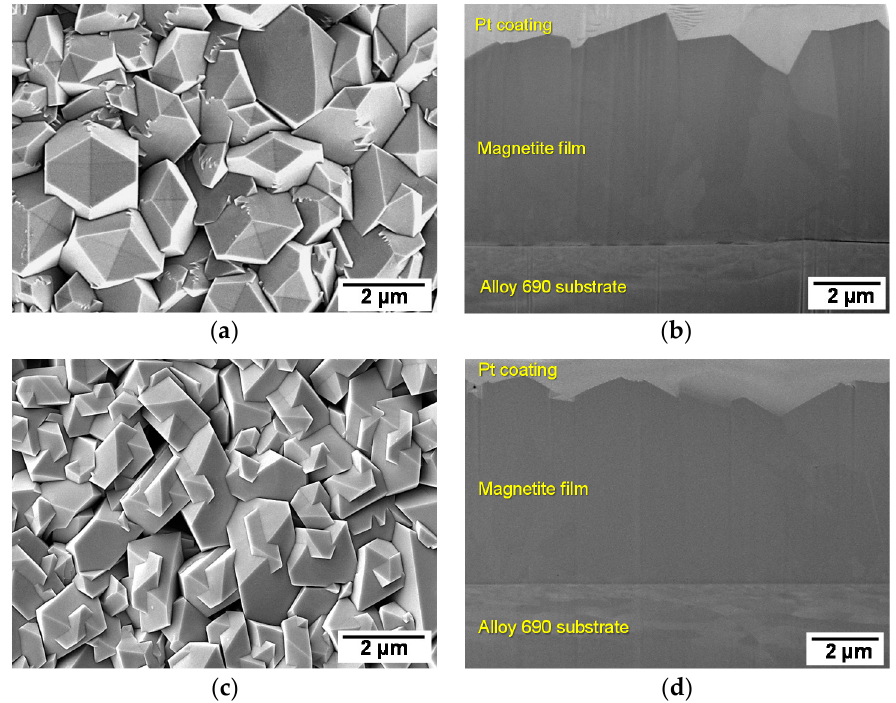
Figure 5. SEM micrographs of the surface and cross section of electrodeposited magnetite films on Alloy 690 substrate before and after the potentiodynamic polarization tests: ( a ) the surface before the test and ( b ) the cross section before the test; ( c ) the surface after the test; and ( d ) the cross section after the test.